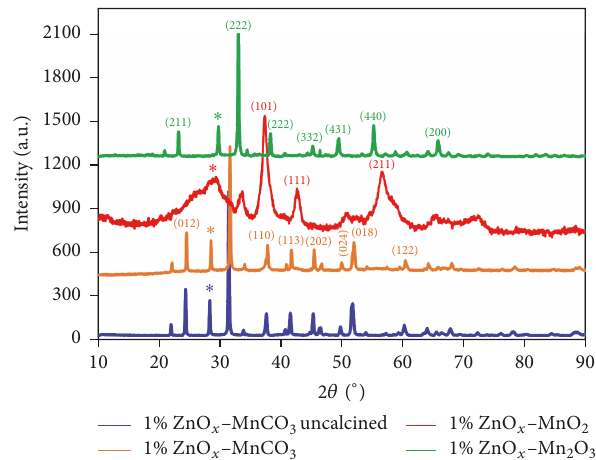
Figure 3: XRD pattern of the catalyst 1% ZnO and catalyst calcined at different temperatures 1% ZnO 1% ZnO –MnO 2 ; and 1% ZnO x